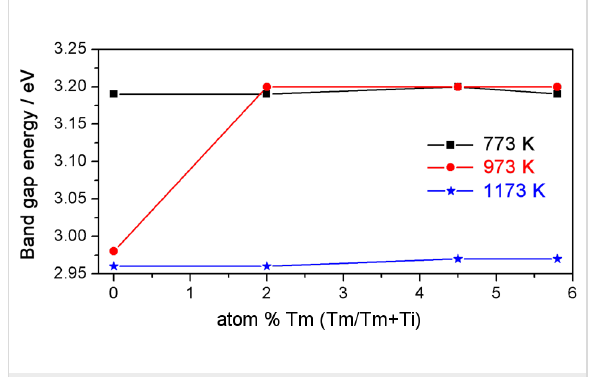
Figure 4: Band gap energy values as a function of Tm doping concen- tration at different annealing temperatures.